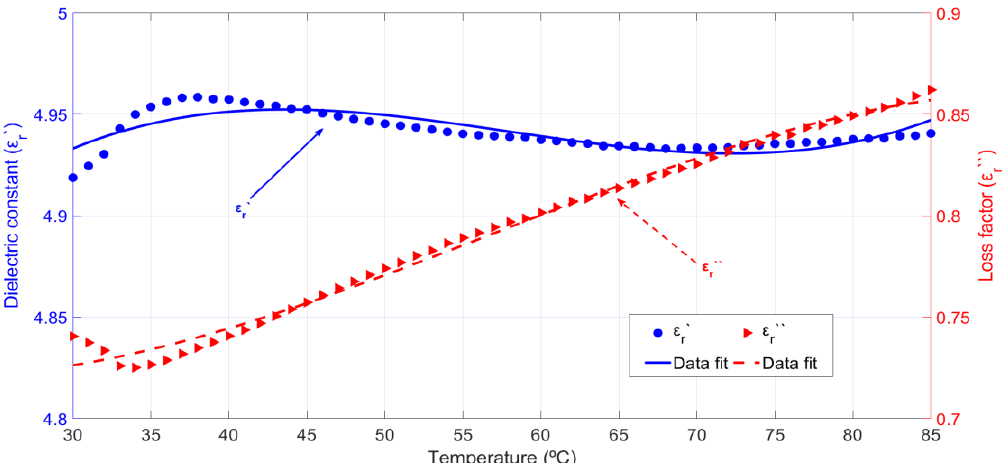
Figure 6. Rockrose biomass permittivity behavior versus temperature and polynomial data fit. The density of samples equal to 0.3 g/cm 3 and the moisture content (dry basis) is around 100%.